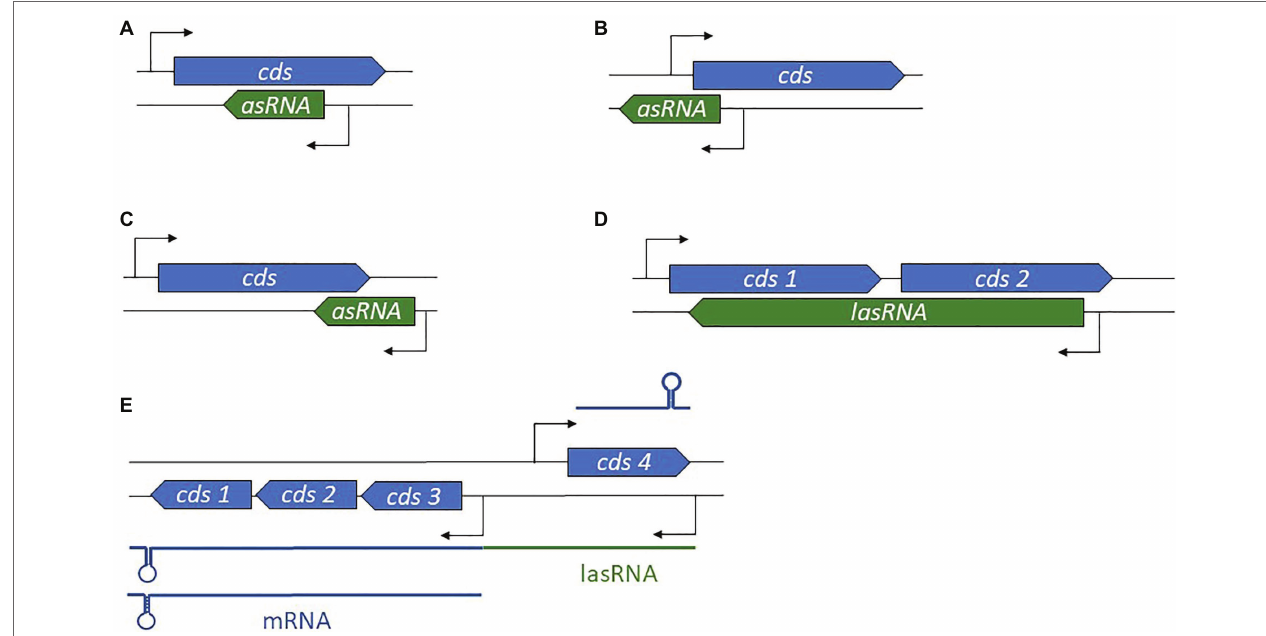
FIGURE 2 | Diversity in antisense RNA (asRNA) genomic locations and lengths. (A) Position of an intragenic asRNA. (B) An asRNA complementary to and overlapping the 5 ' untranslated region (UTR). (C) An asRNA complementary to and overlapping the 3 ' UTR. (D) A long asRNA (lasRNA) covers multiple genes. (E) In the concept of the excludon, an lasRNA controls the expression of an mRNA expressed from the opposite strand, and also encodes mRNA. cds , coding